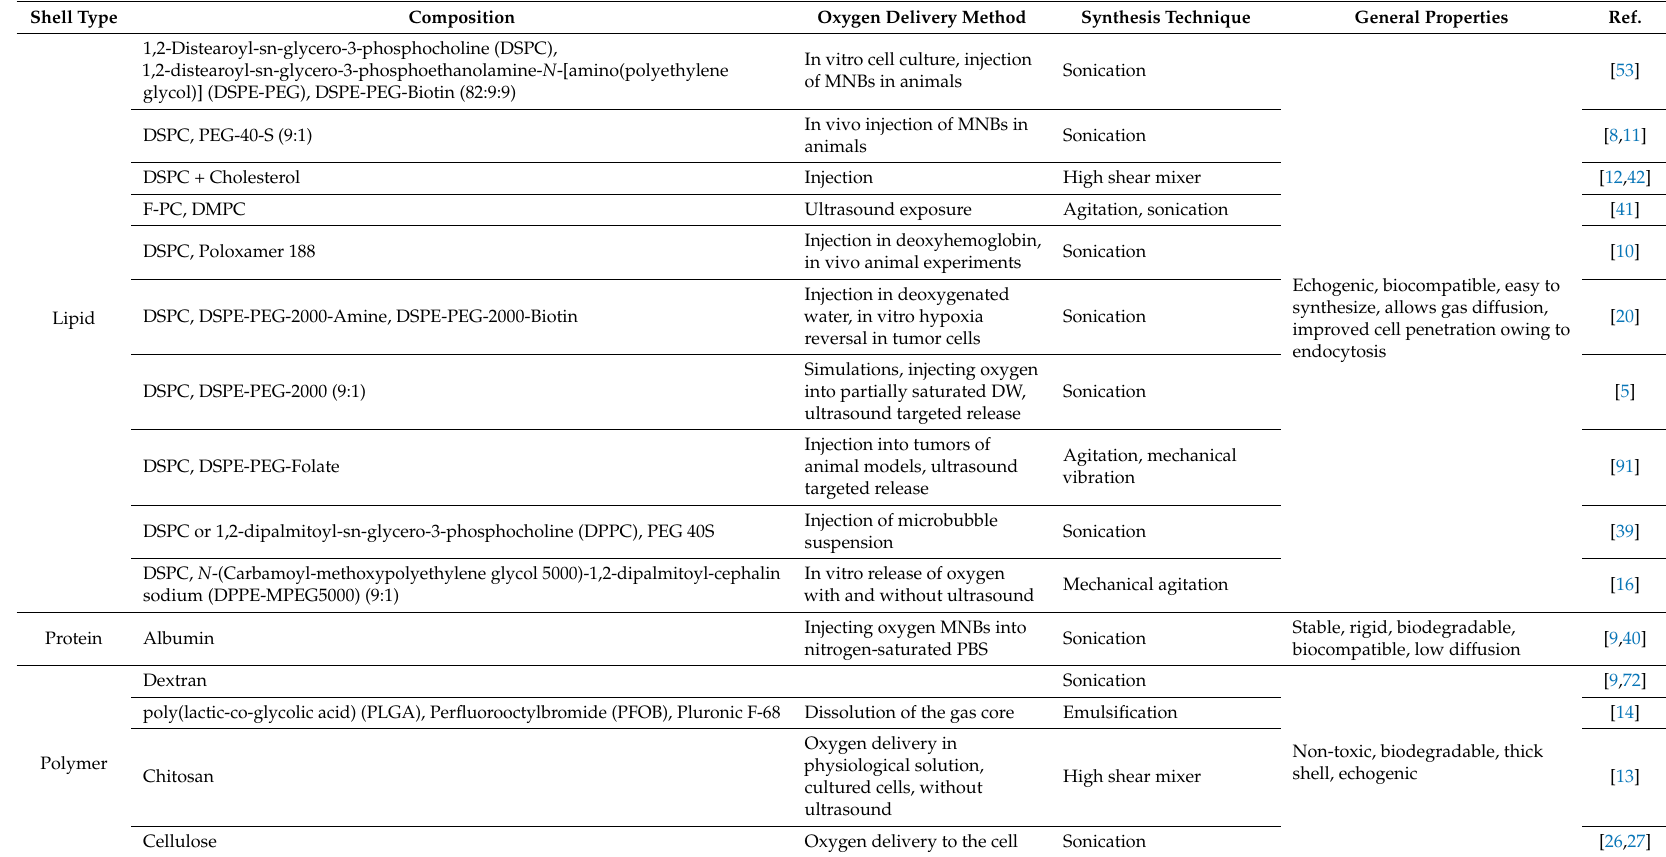
Table 1. Characteristics of MNBs used for oxygen delivery by various